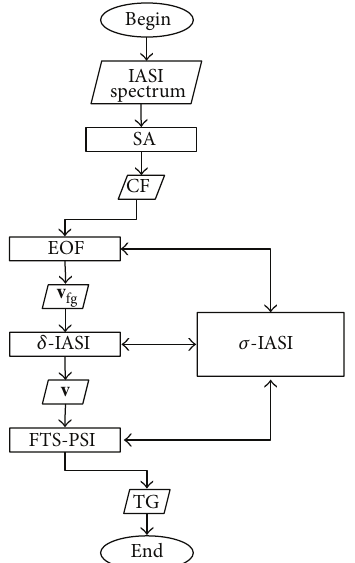
Figure 1: Flow chart of 𝜑 -IASI. The acronym SA stands for scene analysis and its output CF stands for cloud flag. k stands for the thermodynamic state of the atmosphere ( 𝑇 𝑠 , 𝑇 , H 2 O, O 3 ) while the subscript fg is the acronym for first guess. FTS-PSI stands for Fourier transform spectroscopy with partially scanned interferogram. Finally the acronym TG stands for trace gases. The double-way arrows connecting the modules EOF, 𝛿 -IASI, and FTS- PSI with 𝜎 -IASI mean that all these modules use the 𝜎 -IASI code as a